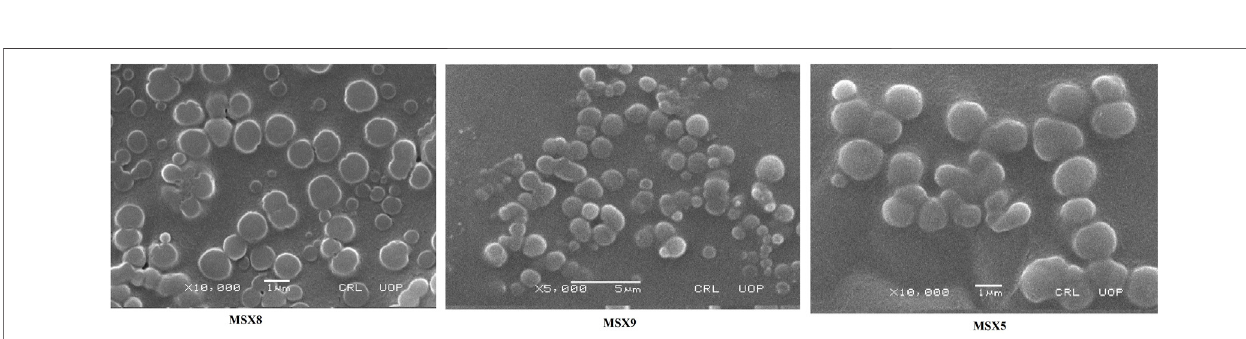
Frontiers in Pharmacology |